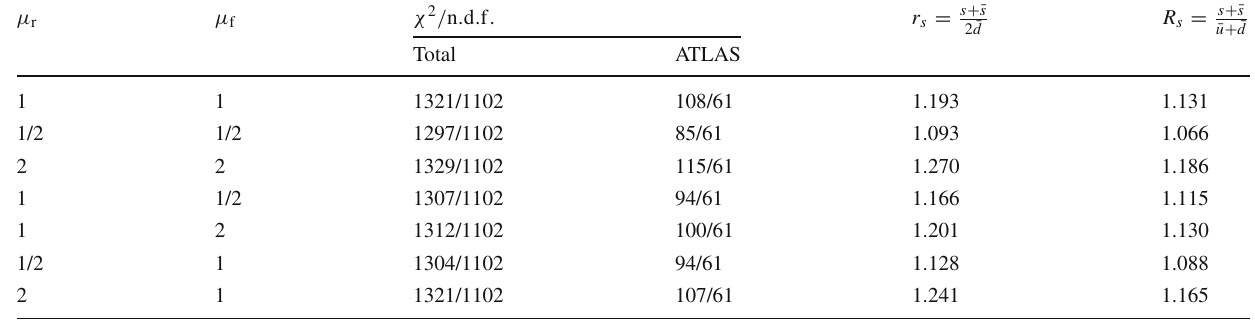
Table 22 Summary of the central value and all uncertainties in the CKM matrix element | V cs | Central value 0 . 969